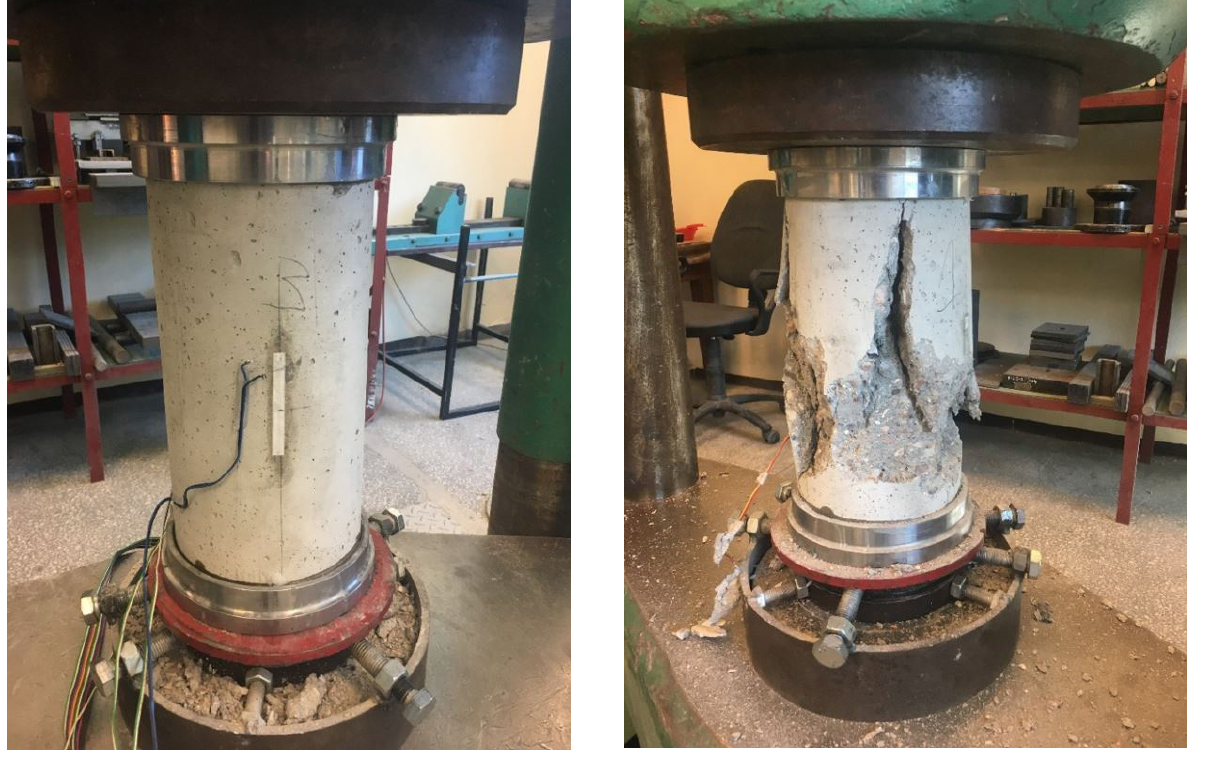
Figure 5: Concrete specimen placed in strength-testing machine. Figure 6: Failed concrete